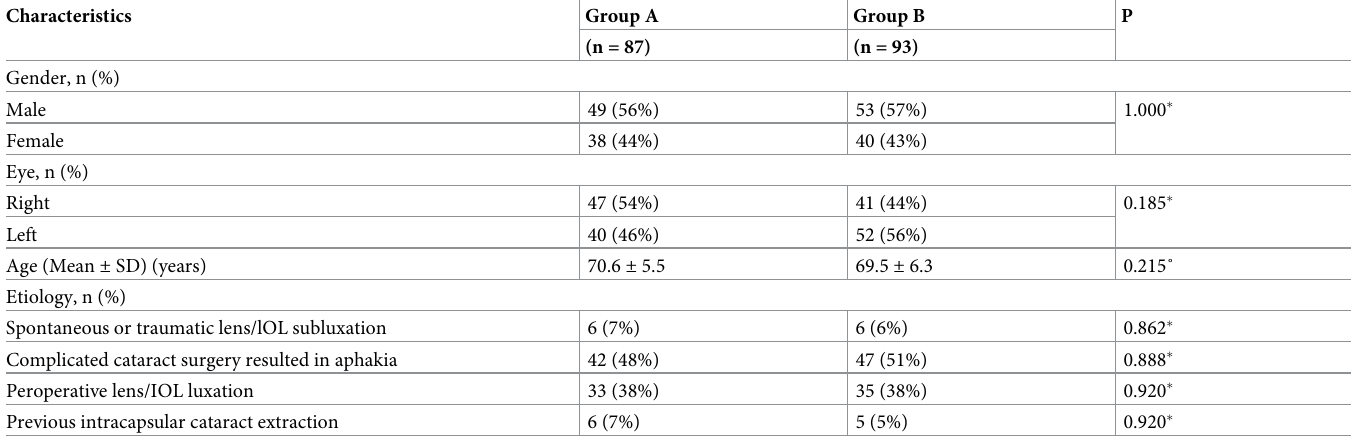
Table 1. Demographics and etiology of aphakia for Group A (anterior chamber iris-claw fixation) and Group B (retropupillary iris-claw implantation). Characteristics